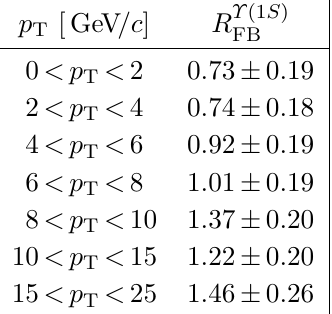
Table 16 . (cid:7) (1 S ) forward-to-backward ratio, R (cid:7) (1 S ) range 2 : 5 < j y (cid:3) j < 4 : 0.